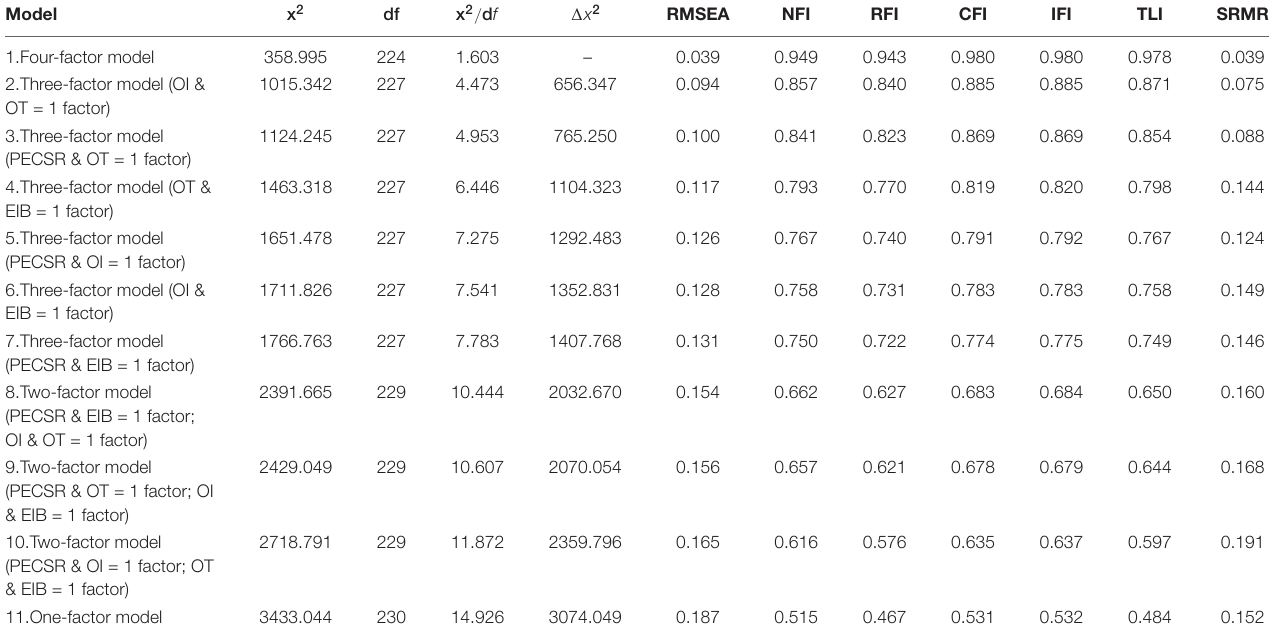
TABLE 2 | Results of confirmatory factor analysis.